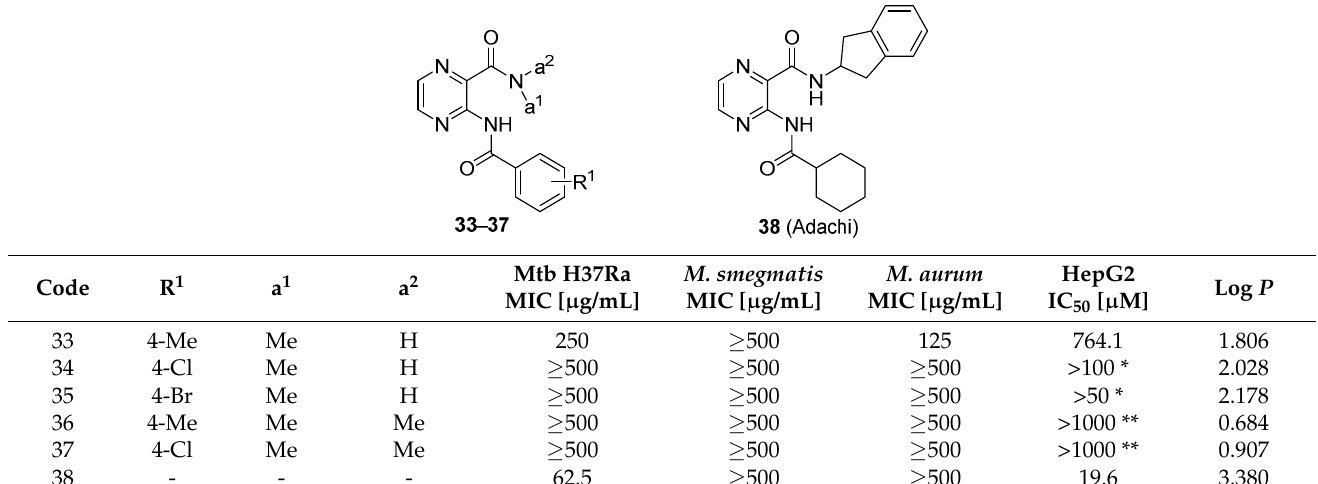
Table 3. Antimycobacterial activity and HepG2 cytotoxicity of compounds with N -methylated carboxamide at C-2.